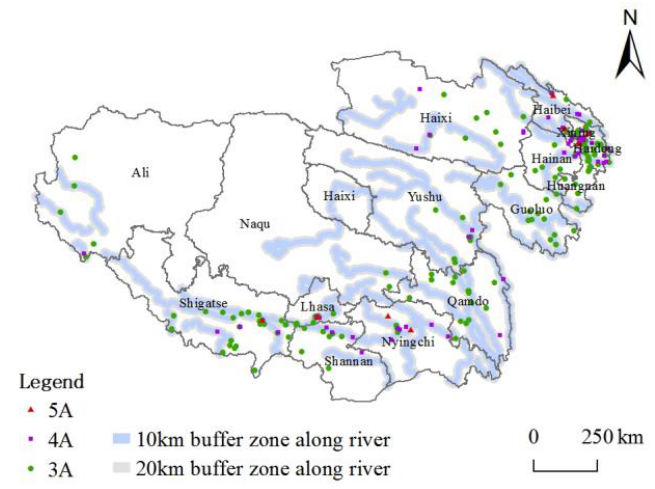
Figure 6. Spatial distribution of tourist attractions and major rivers.